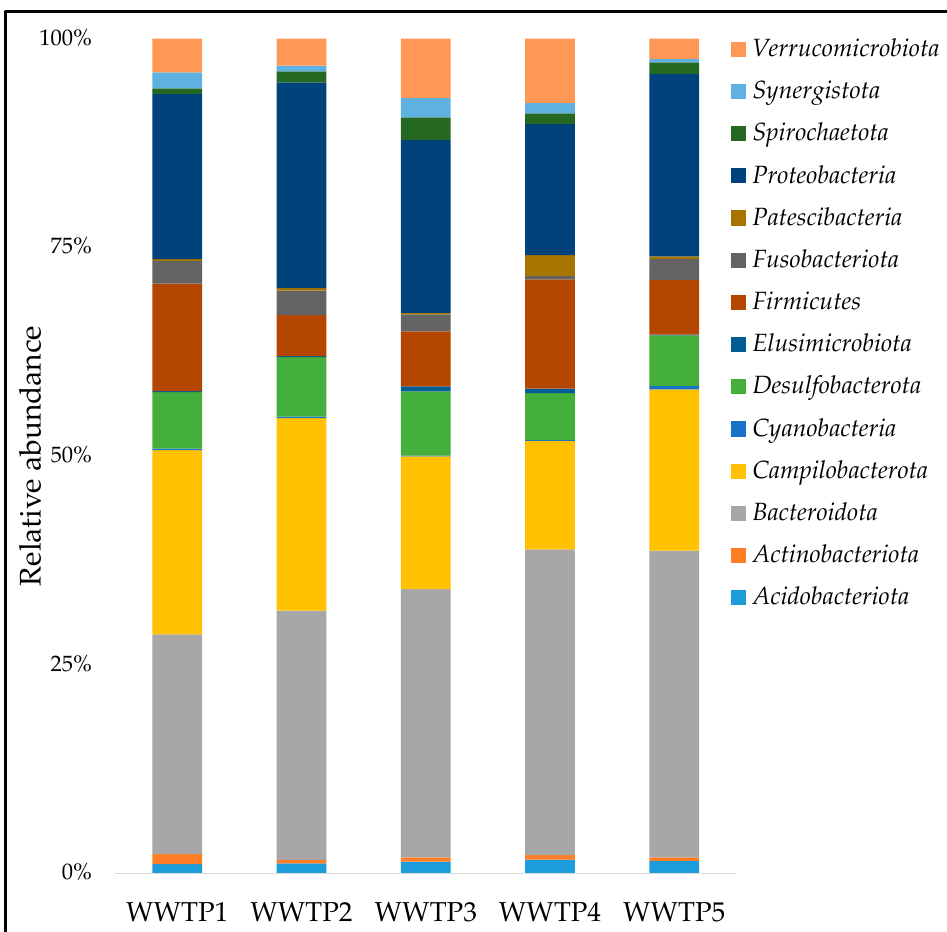
Figure 2. Relative abundance of the predominant phyla in influent wastewater.